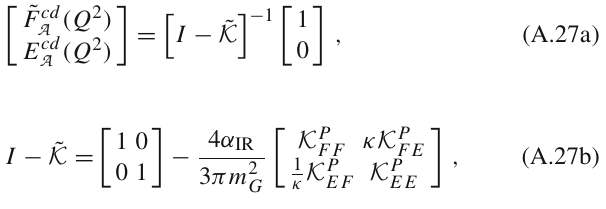
constants (column 6): measured values, where known, from Ref. [70]; and others, marked with “ ∗ ”, drawn from lQCD studies [70,101–104]. (Dimensioned quantities in GeV. Underlined entries from Table